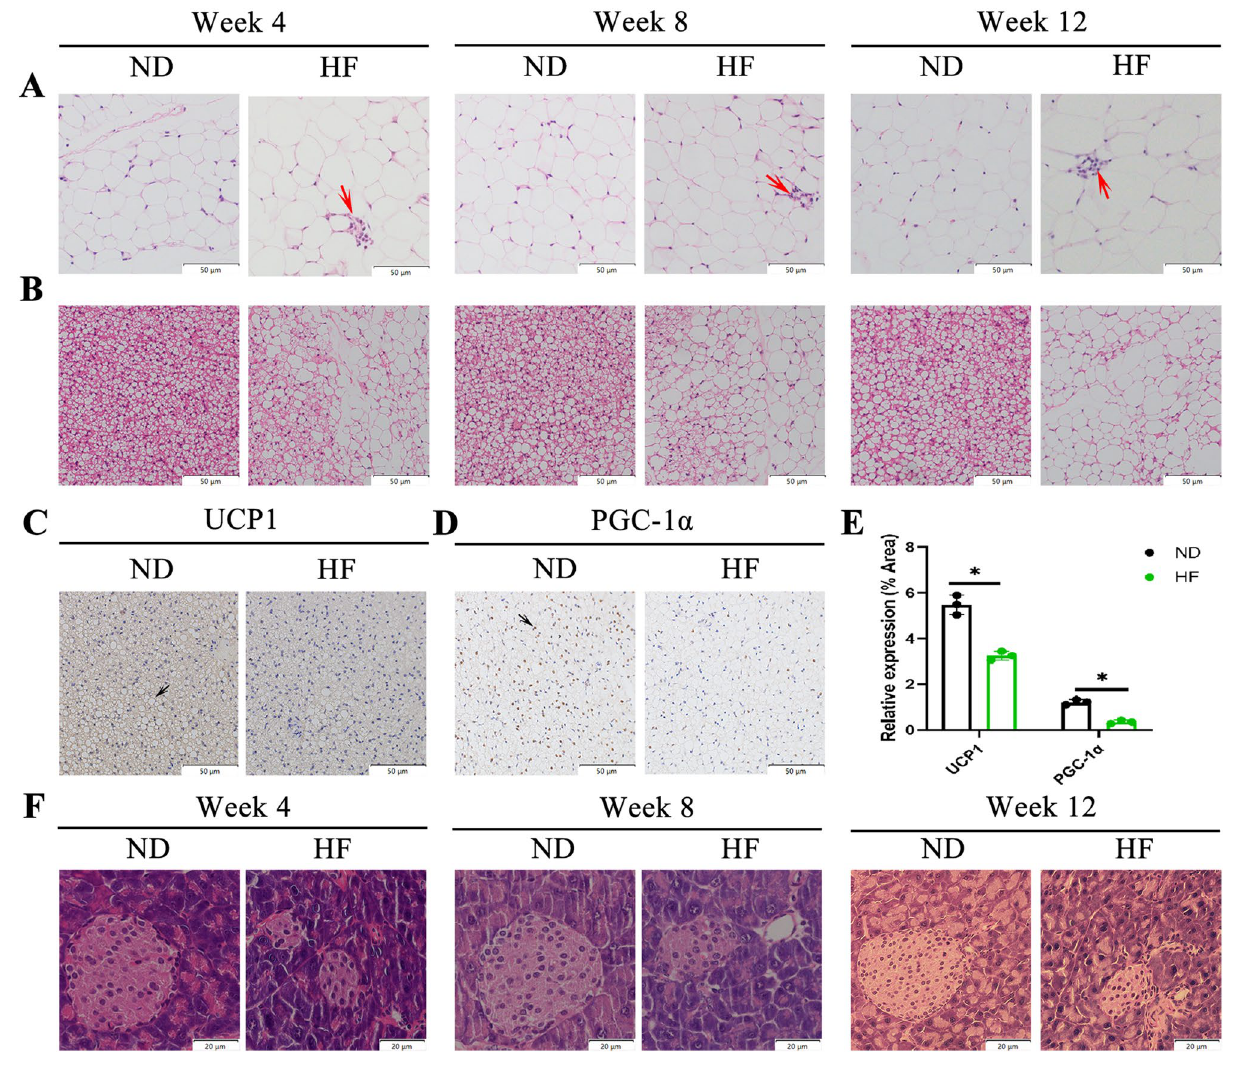
Figure 3. Effects of HF diet on WAT, BAT, and Pancreas. ( A , B ) Representative histological results of WAT and BAT by hematoxylin and eosin staining. Inflammatory foci are annotated with red arrows. Bar: 50 µm. ( C , D ) BAT sections stained with immunohistochemistry for UCP1 and PGC-1α. Bar: 50 µm. ( E ) Quantification of UCP1 and PGC-1α positive cells. ( F ) Representative H & E images of Pancreas. Bar: 20 µm. The student’s t-test was used to determine statistical significance. * p <